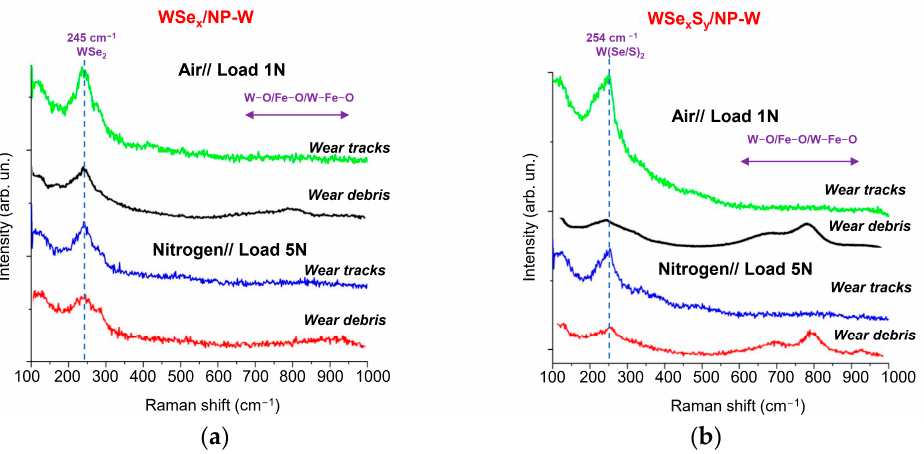
Figure 11. Raman spectra of the ( a ) WSe x /NP-W and ( b ) WSe x S y /NP-W_3.6 coatings measured after the tribotesting in air and N 2 -enriched environment for the center area of wear tracks and the wear debris located near the wear tracks.